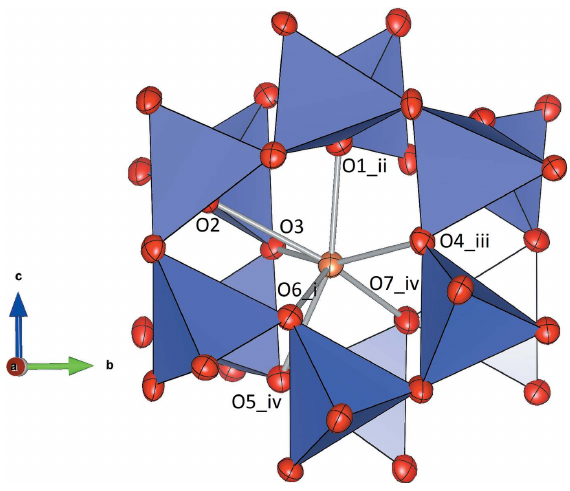
Figure 2 Representation of the coordination polyhedron around Sr1. Displace- ment ellipsoids are drawn at the 70% probability level. [Symmetry codes: (cid:4) y , (cid:4) 1 (cid:4) x , 1 (cid:4) z ; (iv) (i) 1 (cid:4) x , 1 (cid:4) y , 1 (cid:4) z ; (ii) 1 + x , 1 + z ; (iii) 3 + y , 1 2 2 2 2 2 2 (cid:4) 1 (cid:4) y , (cid:4) 1 + x , 1 + z ]. 2 2 2